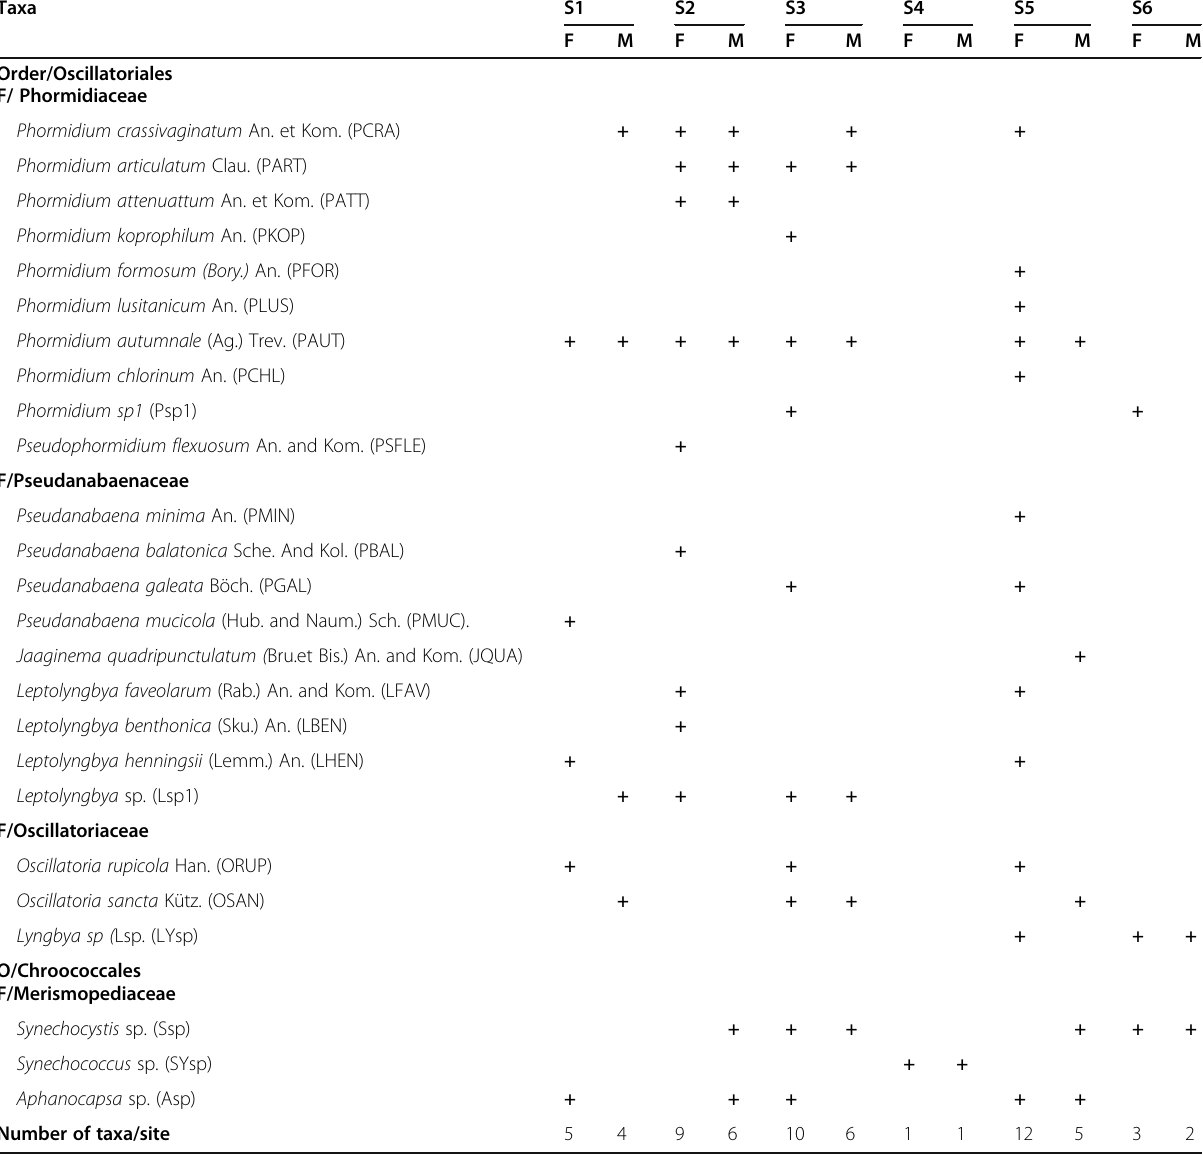
Table 3 Inventory of cyanobacteria taxa in the study sites